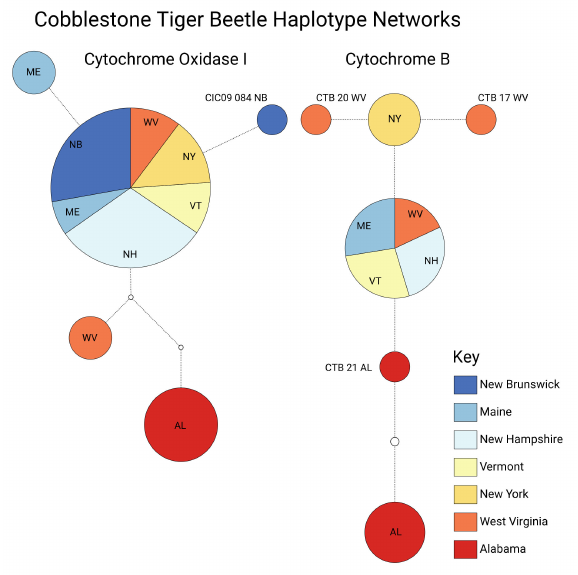
Figure 4. Haplotype networks obtained from the TCS analysis for cytochrome oxidase I (COI) and cytochrome B (CYTB). The size of the circle represents the frequency of each haplotype. Numbers next to small colored circles indicate the individual specimen for that unique circle / haplotype. Empty circles represent hypothetical haplotypes not observed in this study. For the COI network, Clade B comprises only specimens from Alabama, whereas Clade A comprises all other specimens / localities